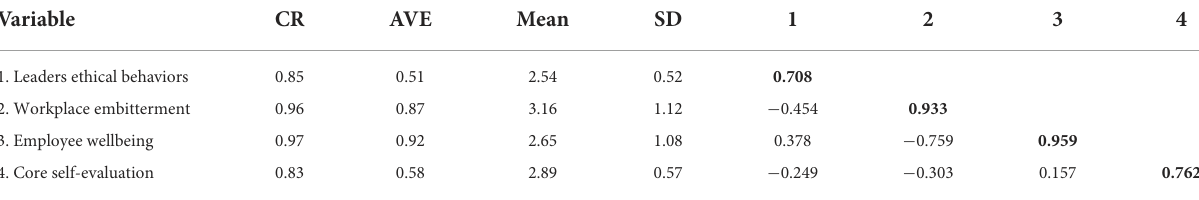
TABLE 4 Descriptive statistics and inter-correlations of study variables.